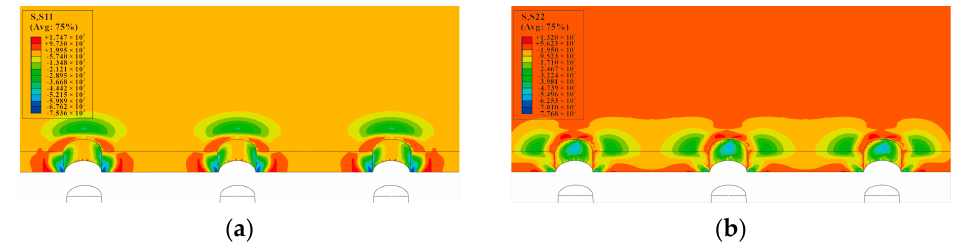
Figure 17. SSCE of the sample with hole spacing four times the hole diameter. The circumferential and radial residual stress nephogram at the hole edge after CE: ( a ) S11/circumferential stress distribution nephogram (MPa); ( b ) S22/radial stress distribution nephogram (MPa).